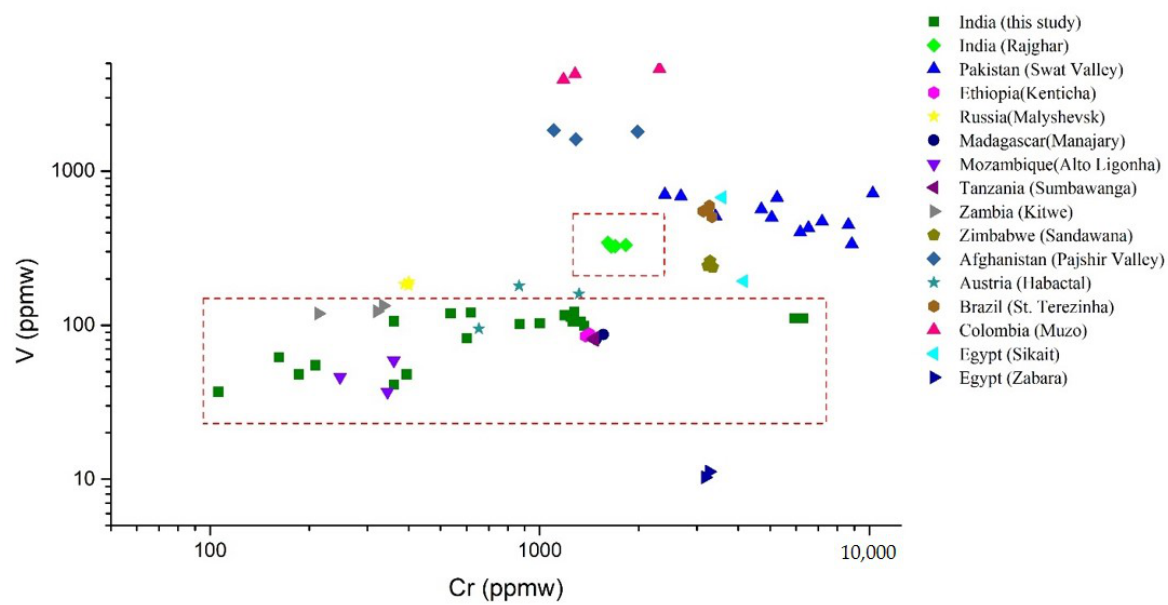
Figure 16. A log-log plot of chromium (Cr) versus vanadium (V) concentrations in emeralds from sixteen deposits. Data are expressed in ppmw. Sources of data are the same as in Figure 14.